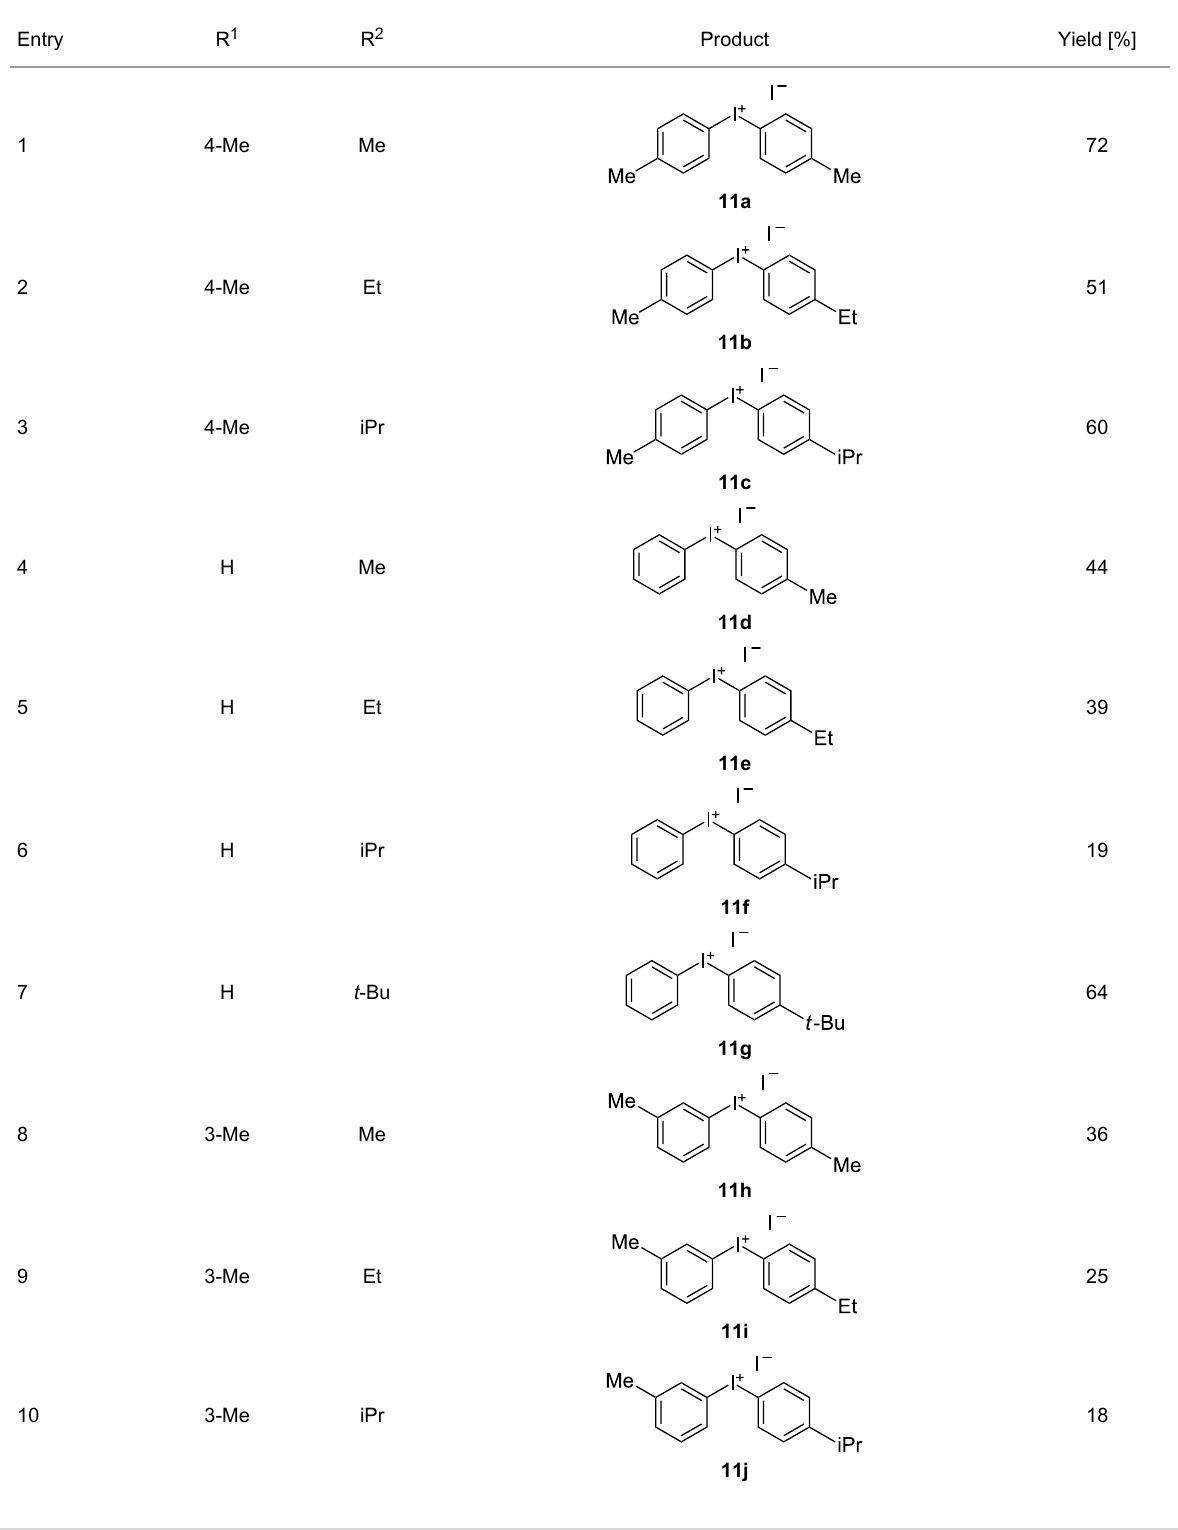
Table 1: Products and yields in the electrochemical generation of diaryliodonium compounds performed in an electrochemical microreactor (30 mA) at a flow rate of 80 µL/min (residence time: 17 s) at 25 °C.